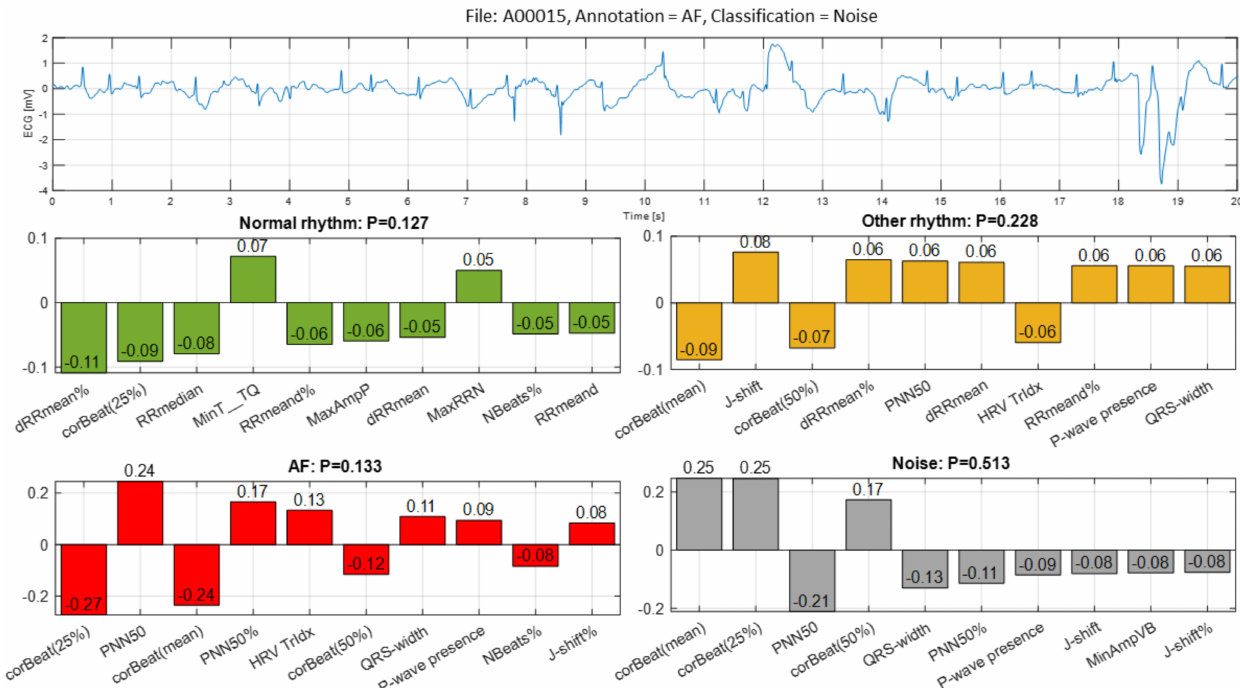
Figure 14. ECG example (file A00015) of erroneously classified AF as Noise. The single-lead ECG strip is representative to significant deflections of the isoelectric line of ‘artifact-type’; not obvious RR irregularity; not clearly seen f-waves of AF. The visual ECG interpretation cannot safely differentiate between sinus rhythm ( ± supra-ventricular extrasystoles) and AF. The barplots represent the Case Feature Importance of the top-10 ranked features, which maximally contribute to the output classification probability ( p ) of four rhythms. The ECG strip is detected as Noise (P = 0.513) due to three top-ranked features representative to large QRS morphology variation. DenseNet-3@128-32-4 model decides with almost equal uncertainty about Other rhythm (P = 0.228), AF (P = 0.133) and Normal rhythm (P =